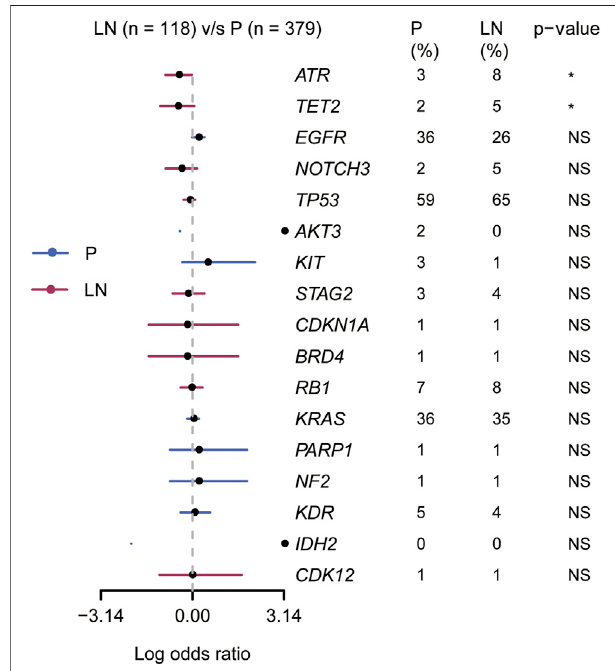
FIGURE 4 | Association of 17 candidate metastasis-related driving genes with primary and lymphatic lesions in the Lung_MSK_2017 cohort.